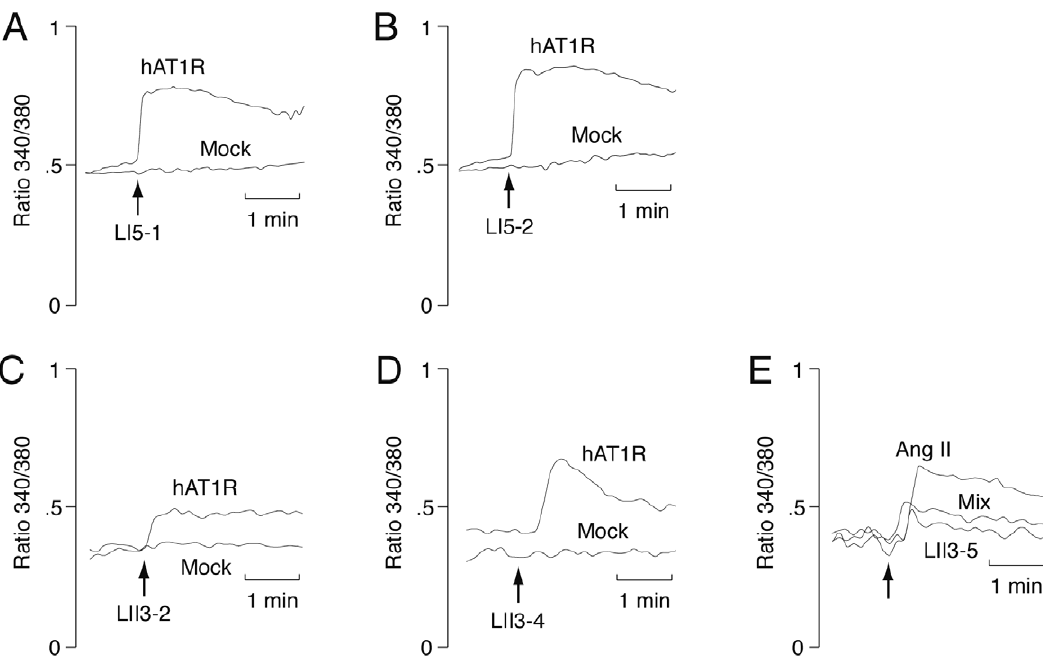
Figure 8. Effect of selected peptides on the concentration of calcium in the hAT1R-expressing cells. Fura-2/AM-loaded hAT1R/CHO-K1 or Mock/CHO-K1 cells were exposed to synthetic octapeptides ( A ) LI5-1 (10 nM), ( B ) LI5-2 (10 nM), ( C ) LII3-2 (10 nM), ( D ) LII3-4 (100 nM), and ( E ) LII3- 5 (1 m M) and/or Ang II (1 nM), respectively, as indicated by the arrows. The results are expressed as Fura-2 fluorescence ratio (340/380 nm).